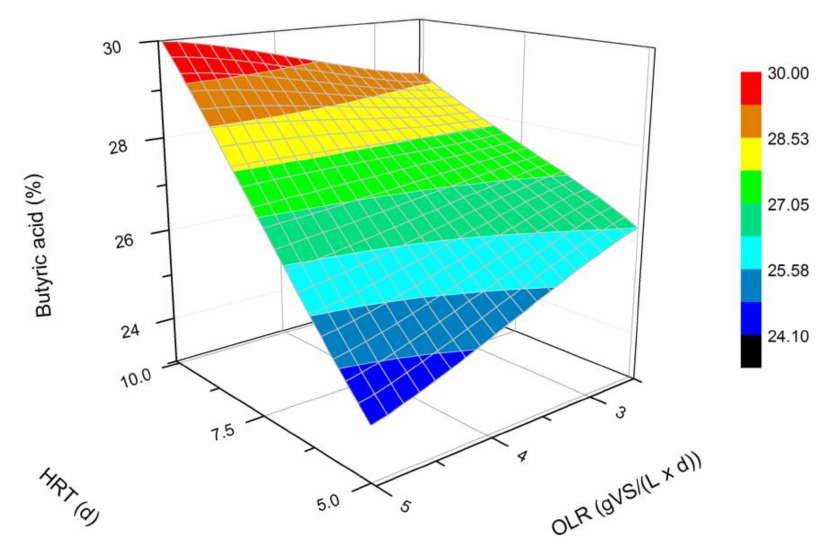
Figure 3. Changes in the content of butyric acid produced in a steady state during the DF process at the OLRs of 2.5 gVS/(L × d) and 5.0 gVS/(L × d) and the HRTs of 5 d and 10